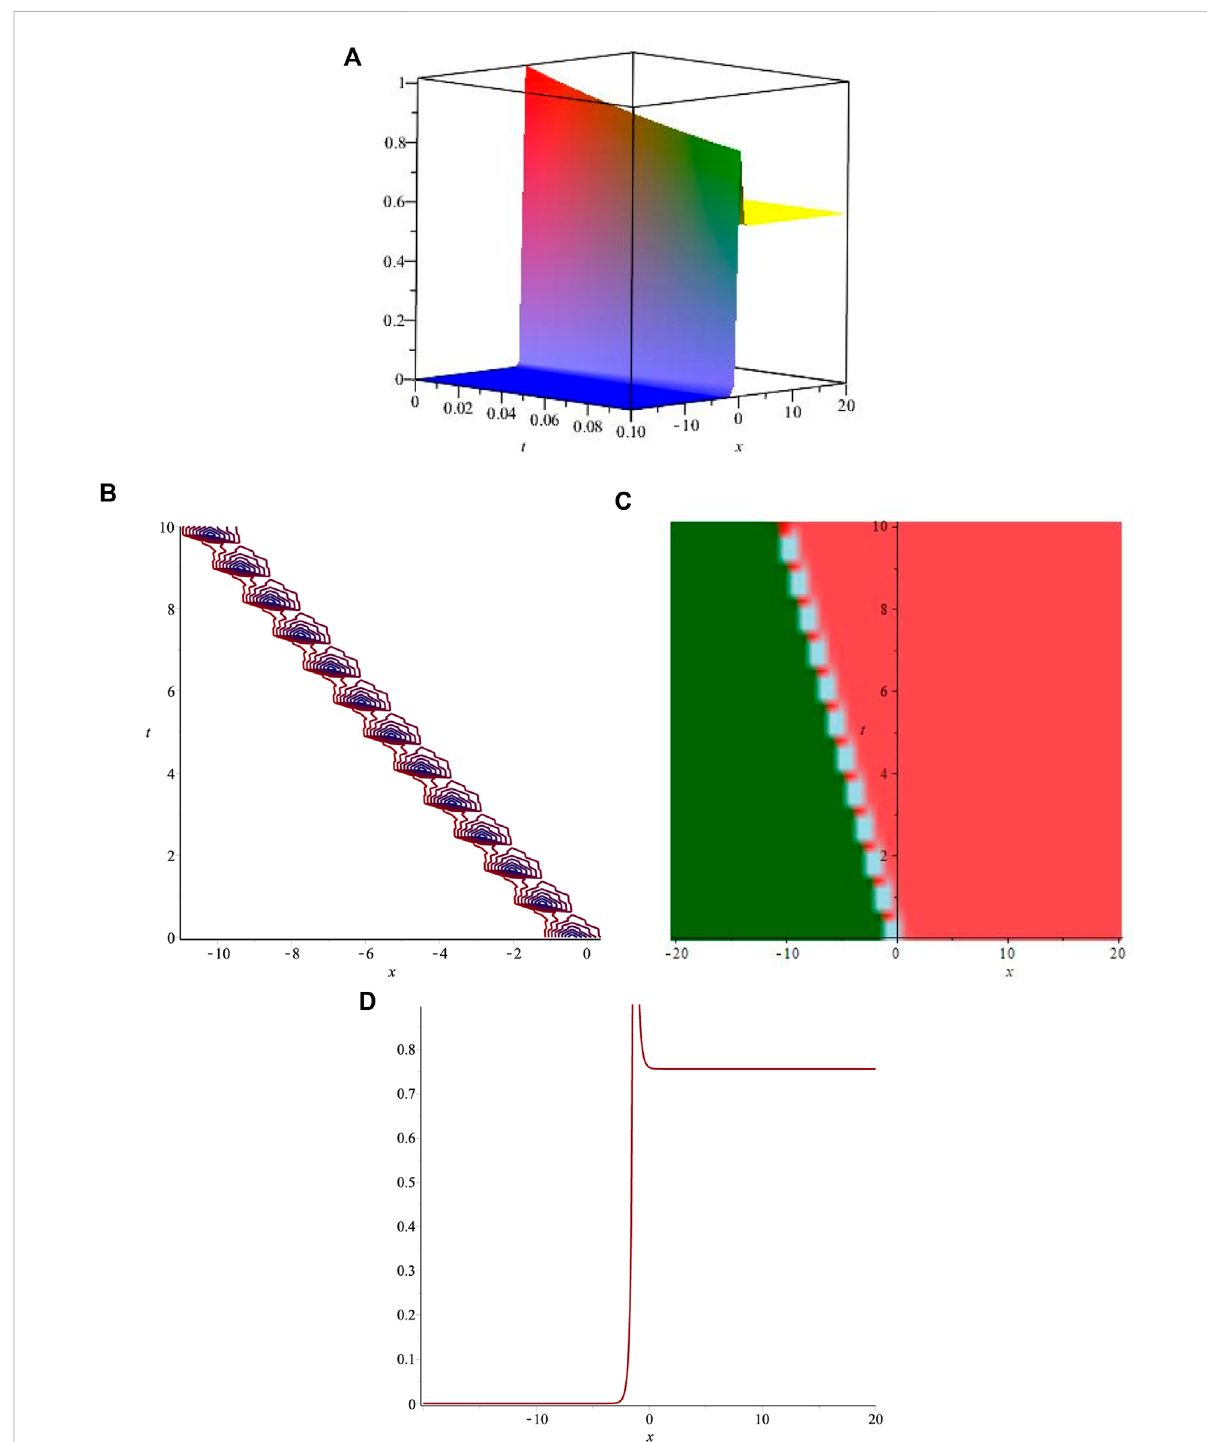
Graphicalrepresentationsof (cid:7) Λ 9 2 ( x , t )(cid:7) 2 for D = ϵ = a = b =0.101, ϑ 1 =0.9, C